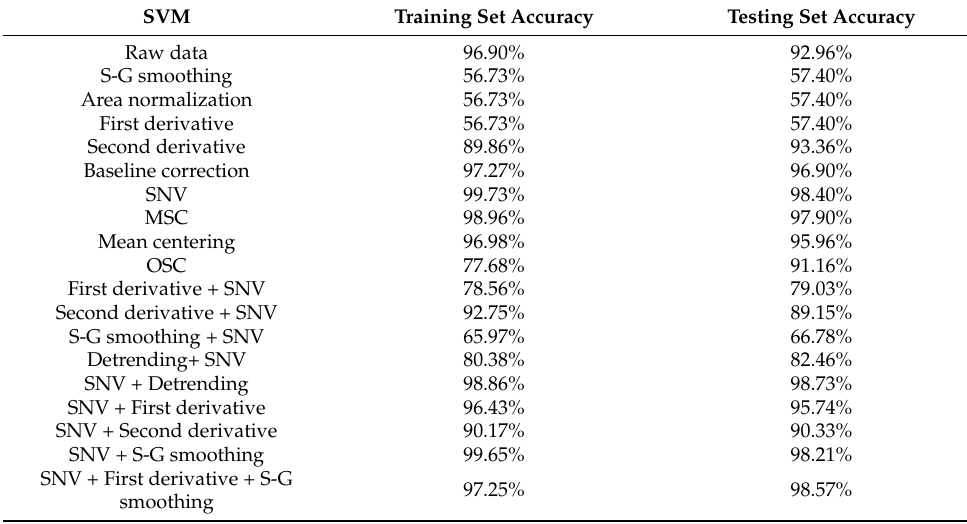
Table 2. Accuracy of Ophiopogon japonicus sets based on